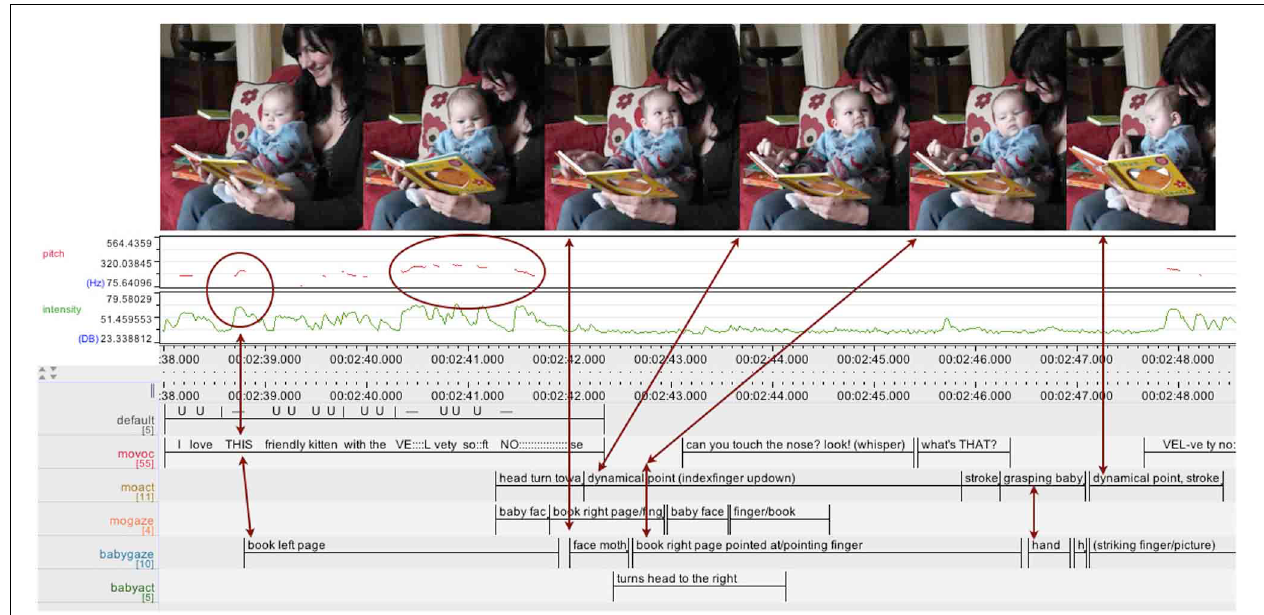
FIGURE 7 | ELAN analysis detail showing pitch (red) and intensity (green) curves. This book sharing interaction at 4 months unfolds as smooth interplay between the actions of caregiver and infant: the infant’s attention is